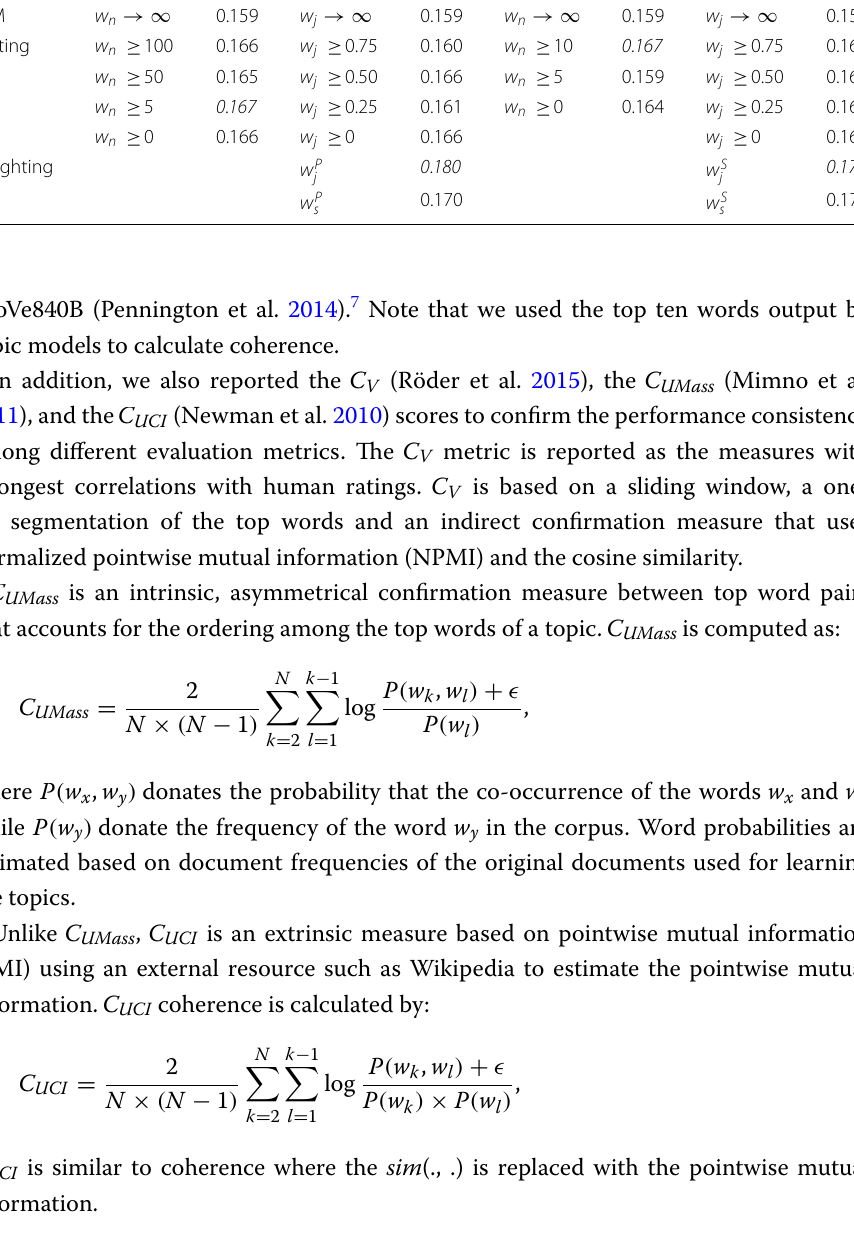
Table 2 Coherence scores of topics from G ′